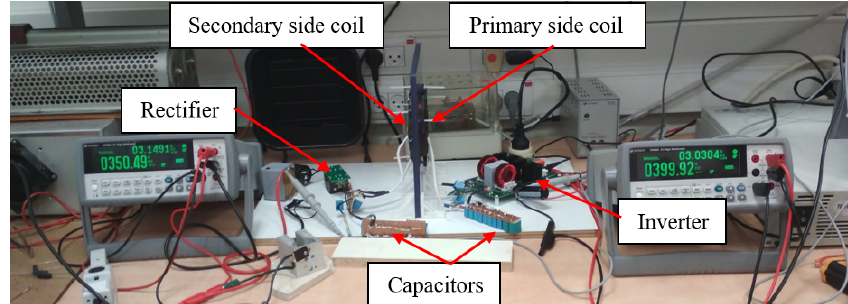
Figure 5. Experimental setup.